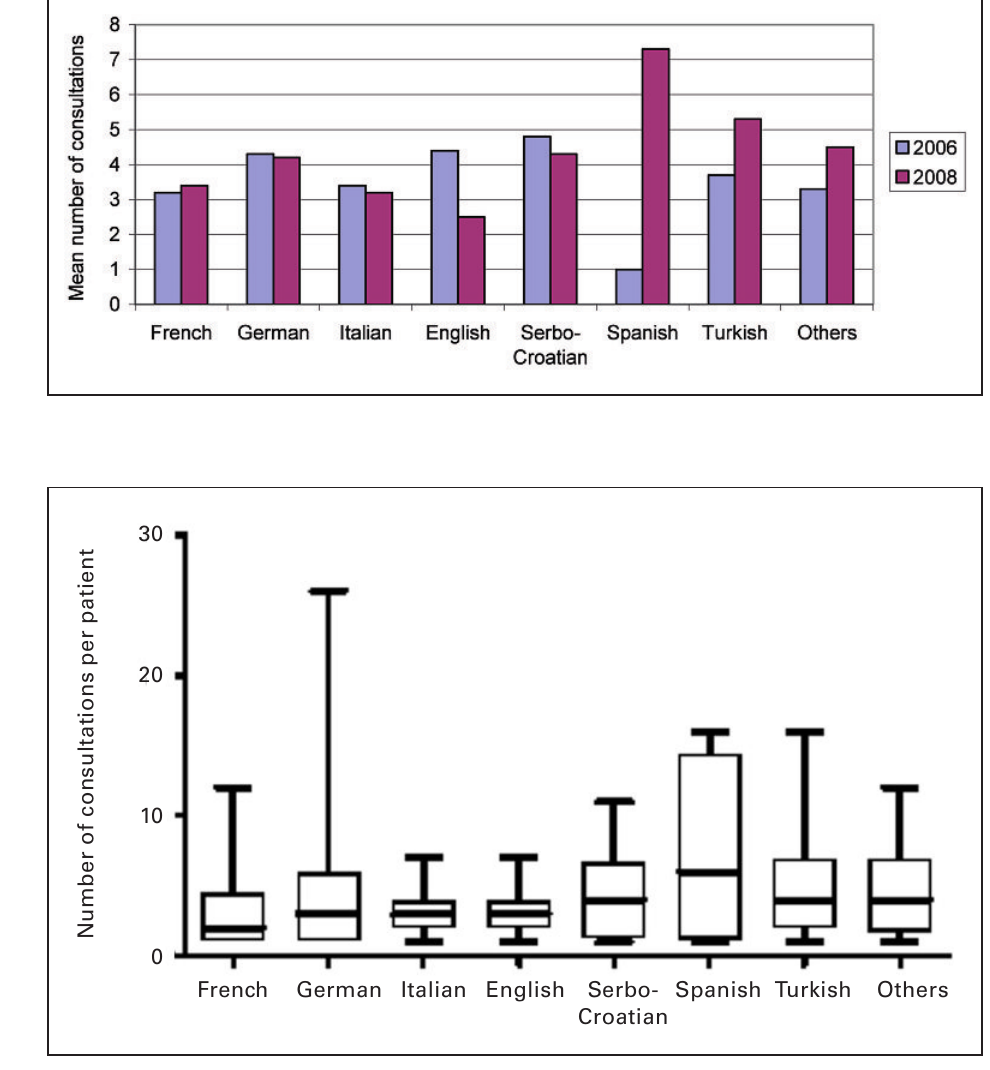
Figure 1 Number (mean) of consultations per patient per mother tongue in 2006 and 2008.